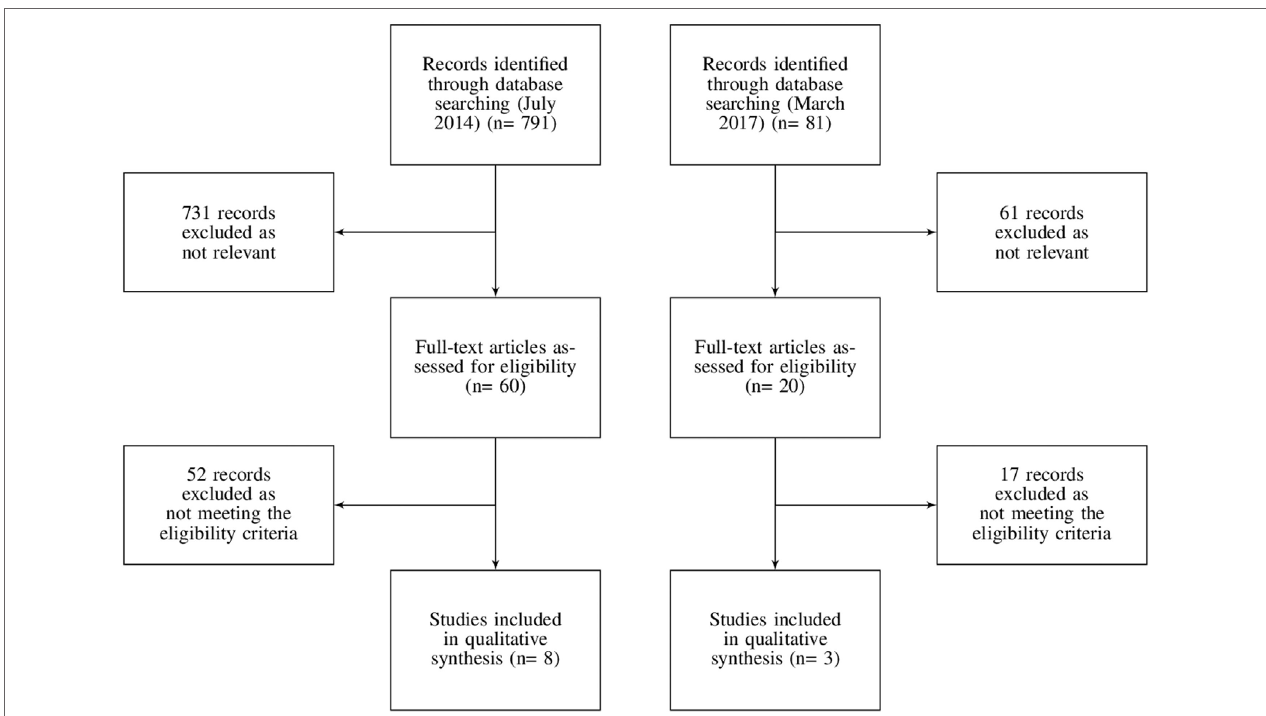
FigURe 1 | Flowchart of the records search and